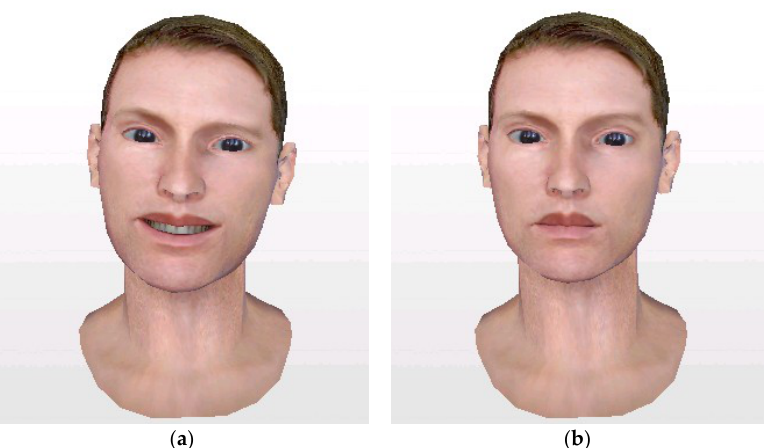
Figure 4. Screenshot of the virtual human with a happy ( a ) and a neutral ( b ) expression.